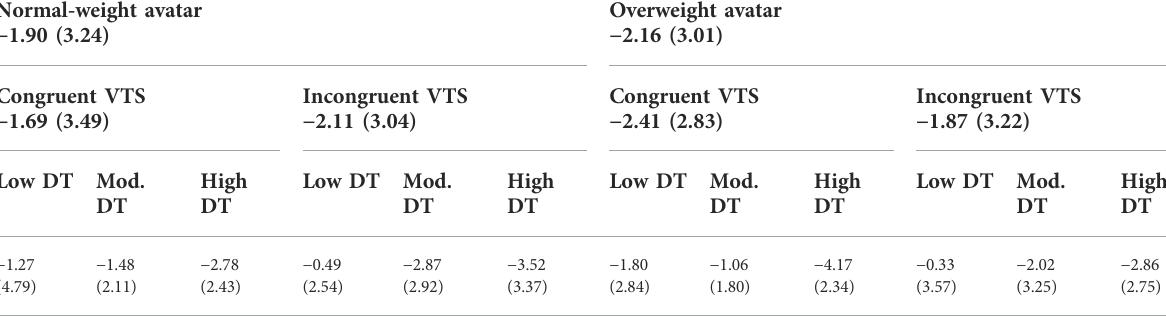
TABLE 2 Means (SD)s of body-size discrepancy per experimental